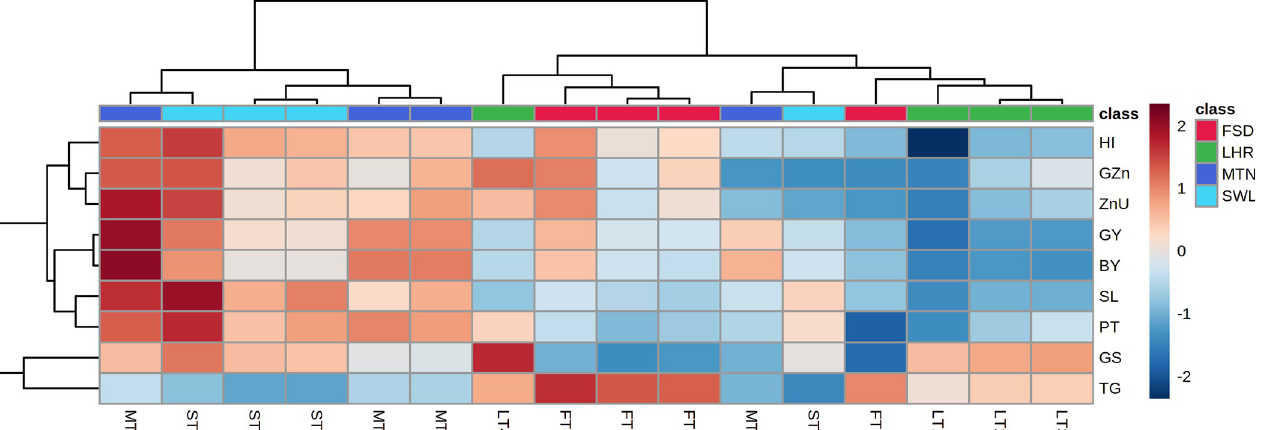
PLOS ONE | https://doi.org/10.1371/journal.pone.0282615 March 9,